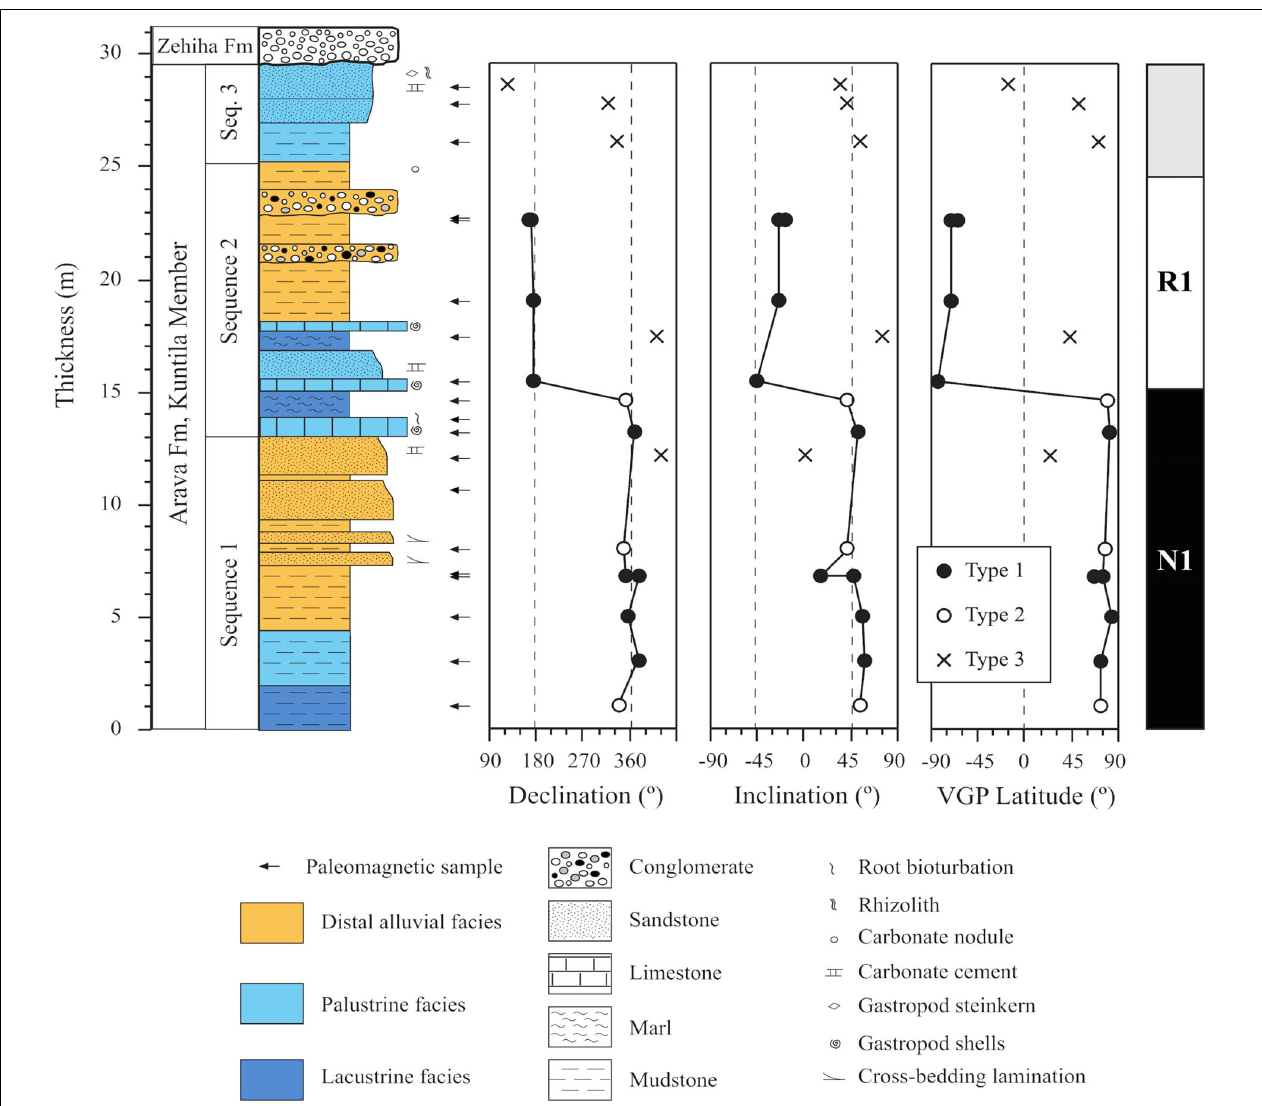
FIGURE 3 | Stratigraphic log of the Kuntila section, magnetostratigraphic results and the sequence of polarity zones identified in the section. The gray bar marks the position of the part of the sequence with uncertain